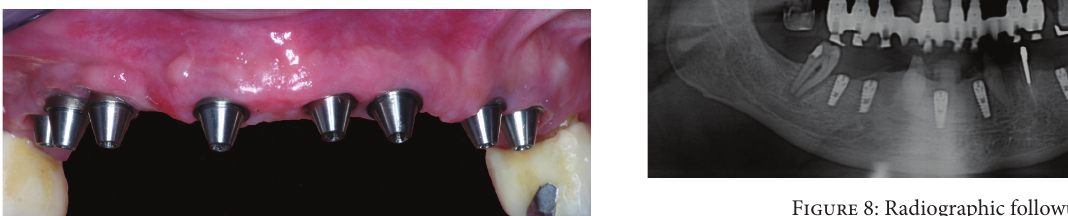
Figure 8: Radiographic